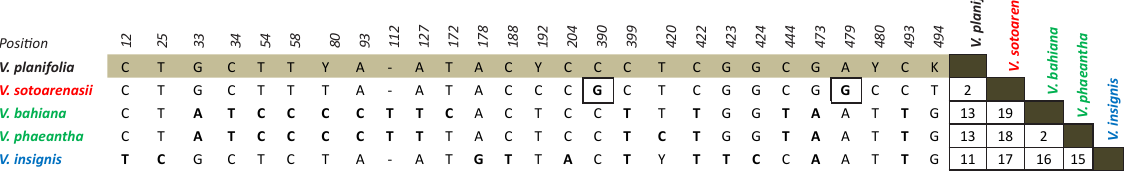
Table 3. Inter-clade polymorphisms of within-clade-conserved nucleotides along the partial ITS sequence of Vanilla planifolia Jacks. ex Andrews, V. sotoarenasii M.Pignal, Azofeifa-Bolaños & Grisoni sp. nov. and their most closely related species. The triangular matrix on the right indicates the number of polymorphic sites between species. Nucleotides diverging from the V. planifolia sequence are in bold. Y = C or T, K = G or T.